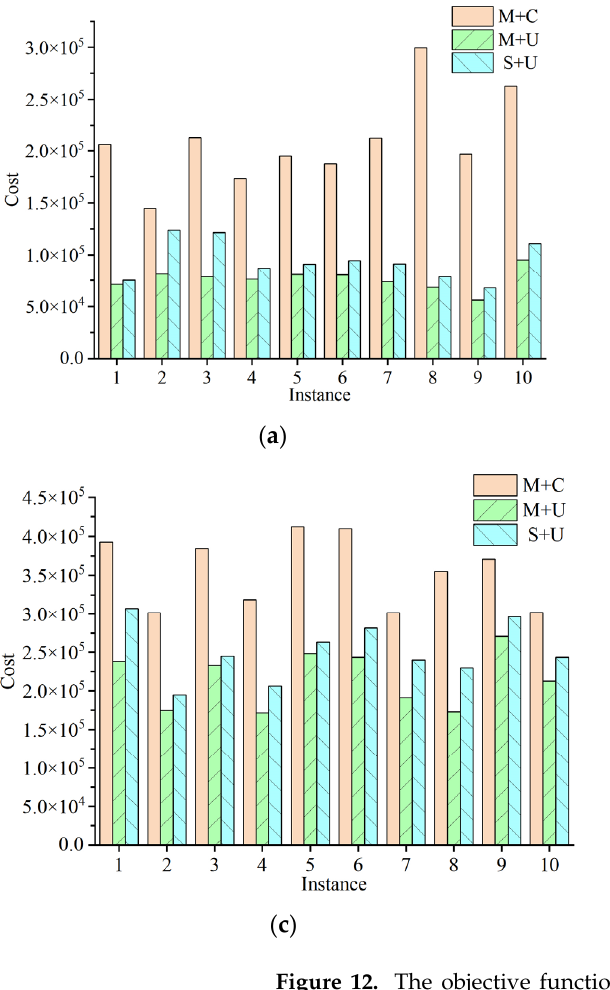
Figure 12. The objective function value for each scheduling strategy under different instances. ( a ) Number of vessels is 20; ( b ) number of vessels is 30; ( c ) number of vessels is 40. (Source: compiled by authors).